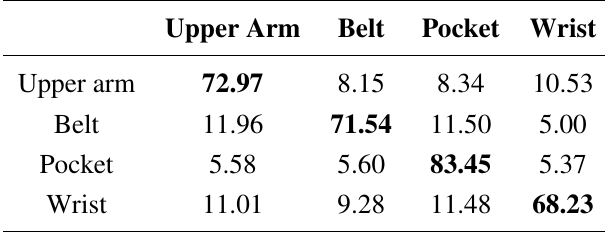
Table 3. Confusion matrices with motion-related features, Dataset 2 (random forest).